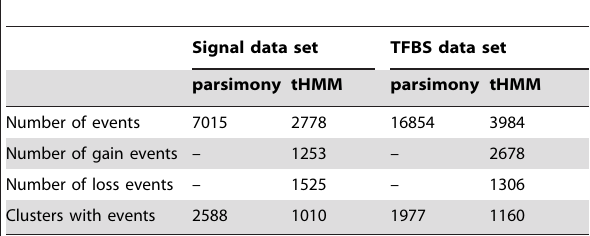
Table 1. Events statistic for the both data sets.